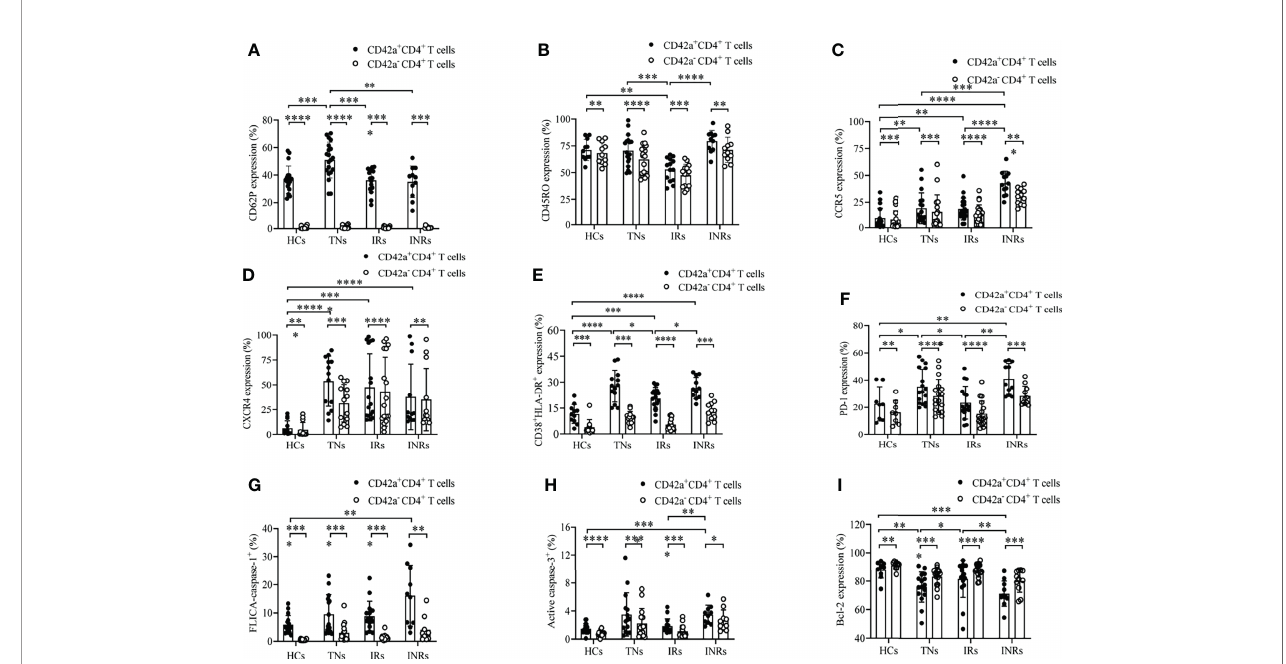
FIGURE 2 | Phenotype of platelet-CD4 + T cell aggregates in HCs, TNs, IRs, and INRs. The phenotypic characteristics of platelet-CD4 + T cell aggregates were analyzed, including platelet activation, CD45RO expression, HIV-1 co-receptors, immune checkpoint receptors, activation markers, and pyroptosis/apoptosis markers, as well as anti-apoptotic proteins from HCs, TNs, IRs, and INRs. Platelet-CD4 + T cell aggregates and platelet-free CD4 + T cells were compared with regards to their expression of CD62P (A) [HCs (n=19), TNs (n=20), IRs (n=16), and INRs (n=11)], CD45RO (B) [HCs (n=11), TNs (n=18), IRs (n=14), and INRs (n=11)], CCR5 (C) [HCs (n=17), TNs (n=18), IRs (n=21), and INRs (n=12)], CXCR4 (D) [HCs (n=13), TNs (n=13), IRs (n=17), and INRs (n=12)], CD38/HLA-DR (E) [HCs (n=11), TNs (n=13), IRs (n=17), and INRs (n=11)], PD-1 (F) [HCs (n=8), TNs (n=17), IRs (n=17), and INRs (n=11)], caspase-1 (G) [HCs (n=16), TNs (n=15), IRs (n=15), and INRs (n=10)], caspase-3 (H) [HCs (n=16), TNs (n=15), IRs (n=16), and INRs (n=10)], and Bcl-2 (I) [HCs (n=10), TNs (n=16), IRs (n=16) and INRs (n=11)]. * P < 0.05, ** P ≤ 0.01, *** P ≤ 0.001, **** P ≤